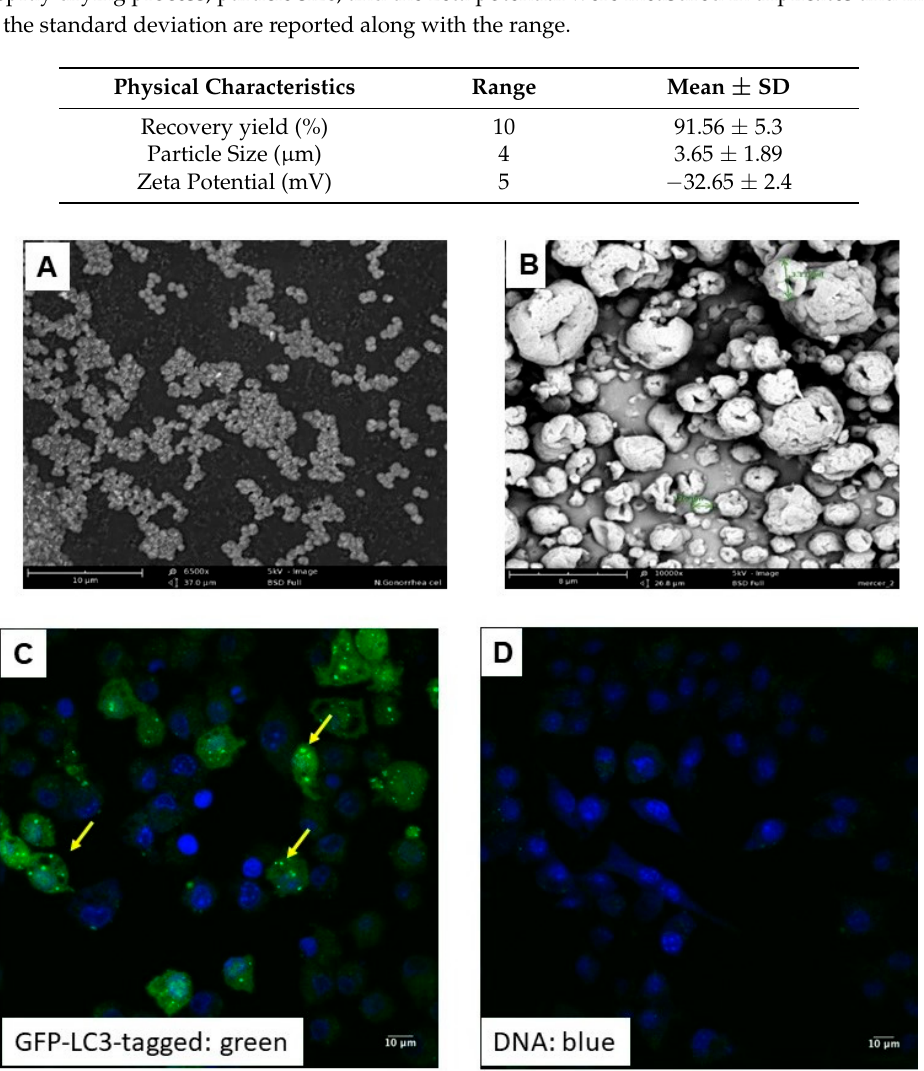
Figure 1. Characterization of formalin fixed whole-cell N. gonorrhoeae . ( A ) Scanning